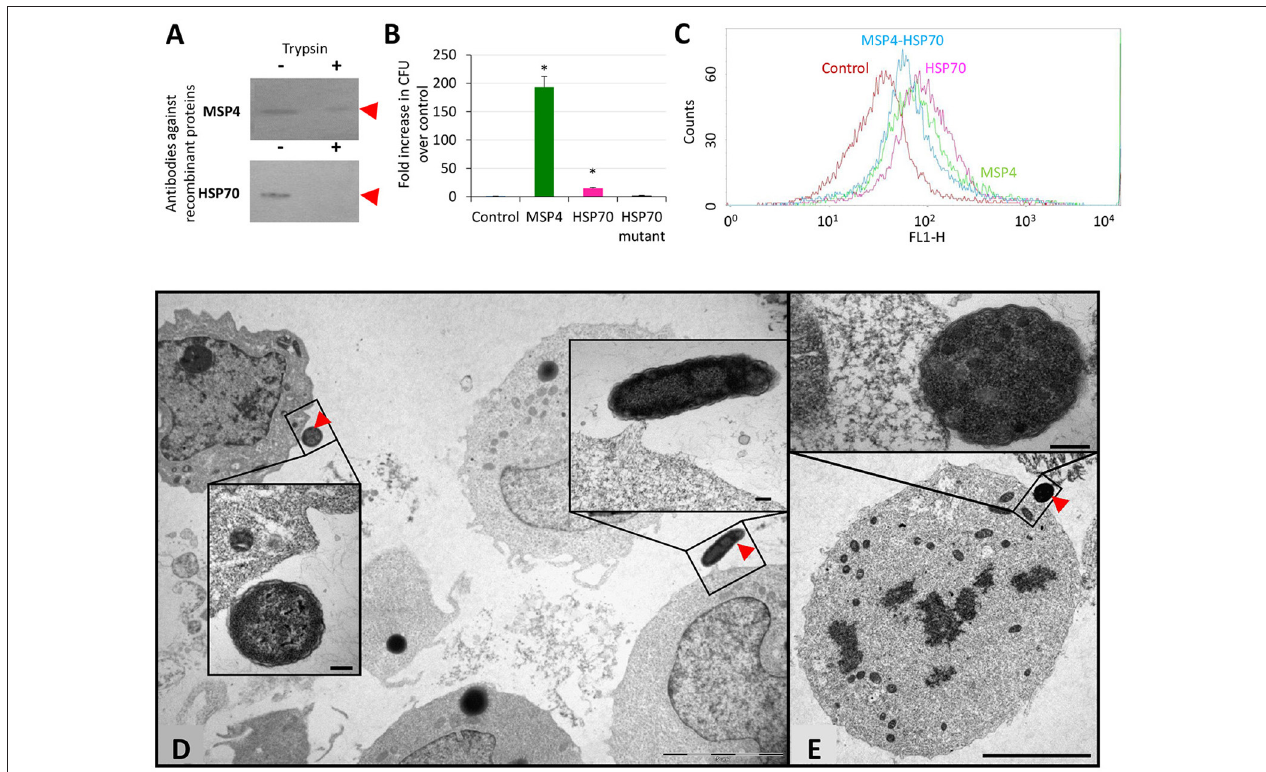
FIGURE 1 | Role of A. phagocytophilum MSP4 and HSP70 proteins in interactions with HL60 human cells. (A) A. phagocytophilum (NY18) purified from infected HL60 human cells were mock treated ( − ) or surface digested with trypsin ( + ) and 10 µ g protein loaded onto polyacrylamide gels for Western blot analysis using rabbit antibodies produced against recombinant proteins. These experiments have been repeated three times with similar results. (B) E. coli strains were grown and induced for the production of recombinant proteins. E. coli cells transformed with expression vector alone were used as negative control (Control). Bacteria adhesion to human HL60 cells was quantitated as the number of colony forming units (CFU) recovered from each test and compared to the control values by Chi2 test. Asterisks denote statistical significant differences between CFU recovered from E. coli transformed with MSP4 or HSP70 and the control ( P < 0.001; N = 2 replicates per treatment). (C) HL-60 cells were incubated with A. phagocytophilum human NY18 isolate in the presence of recombinant MSP4, HSP70 and their combination. HL60 cells incubated with PBS served as negative controls. After washing to remove unbound bacteria and proteins, host cells were incubated for 48 h and binding of recombinant proteins to human host cells was analyzed by flow cytometry. The viable cell population was gated according to forward scatter and side scatter parameters. (D,E) Representative images of the adhesion of recombinant E. coli producing membrane exposed A. phagocytophilum proteins to human HL60 cells. (D) E. coli producing MSP4 or (E) HSP70 were incubated with HL60 cells and revealed by TEM to show adhesion to human cells (arrows). Cells incubated with control bacteria did not show adhesion to HL60 cells. Details of both interacting cells are shown in insets. Scale bars: 5 µ m (D,E) and 200nm